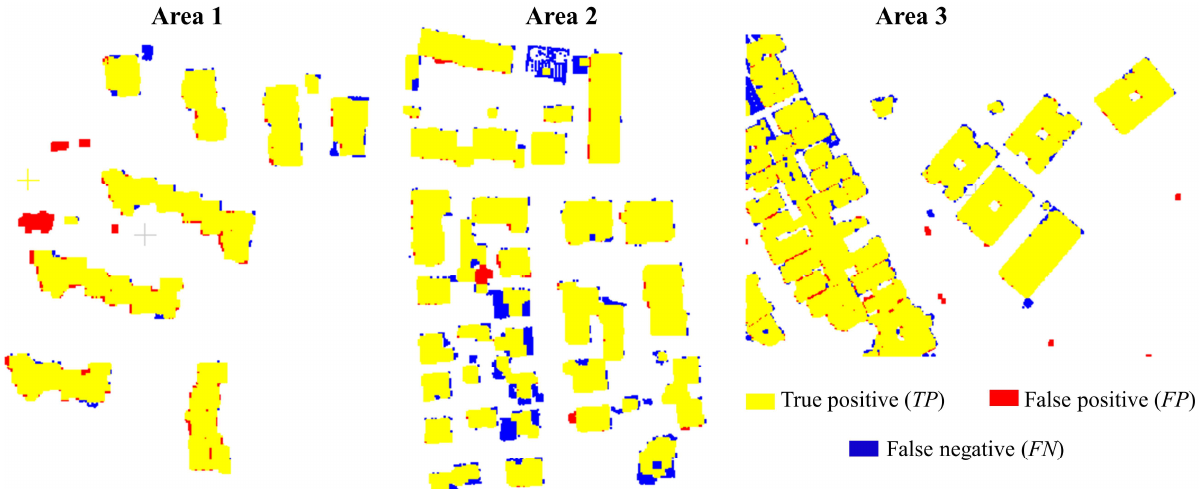
Figure 9. Visualization of building detection result at the per-pixel level for areas 1, 2 and 3. Yellow color represents true positives ( TP ) (building correctly detected), red represents false positives ( FP ) (incorrectly detected as building), and blue corresponds to false negatives ( FN ) (omitted